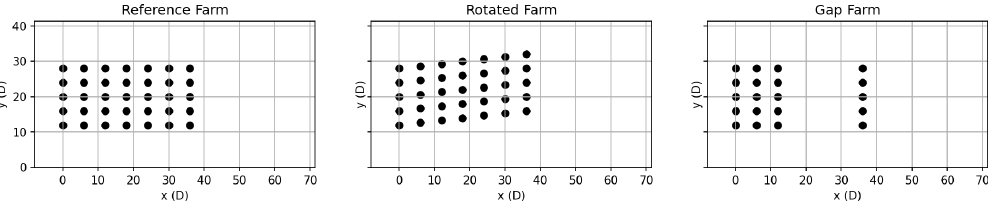
Figure 4. Wind turbine layouts of the wind farms used to validate the farm-scale effect in the CC model. Note that the units on the axes are turbine rotor diameters ( D ) and that axis dimensions match the simulation domain dimensions in SOWFA.